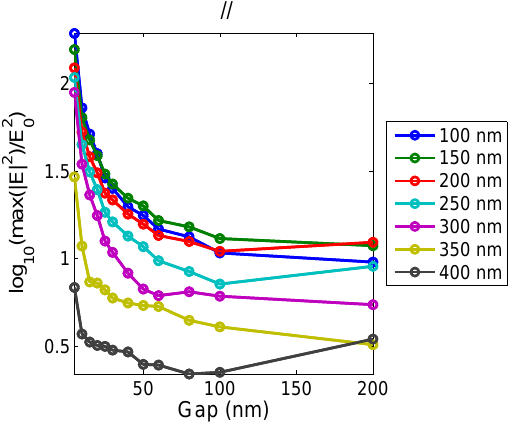
Figure 7: Intensity enhancement in the gap between the two